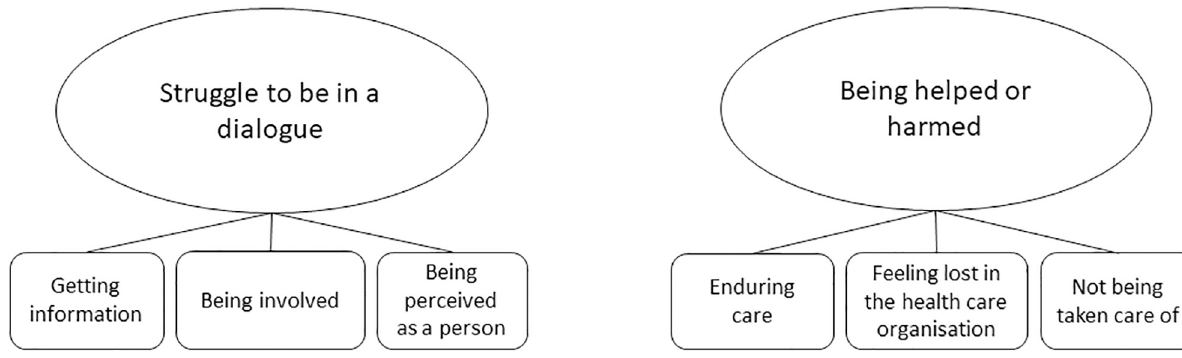
Fig 2. Study themes and sub-themes regarding patients’ healthcare experiences regarding their cirrhosis illness.